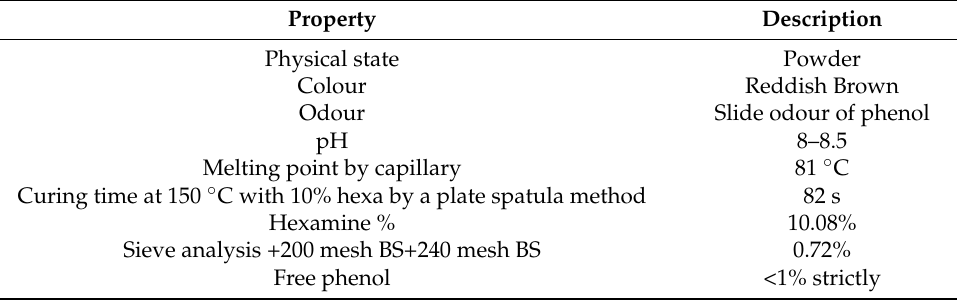
Table 3. Properties of Bio-phenolic